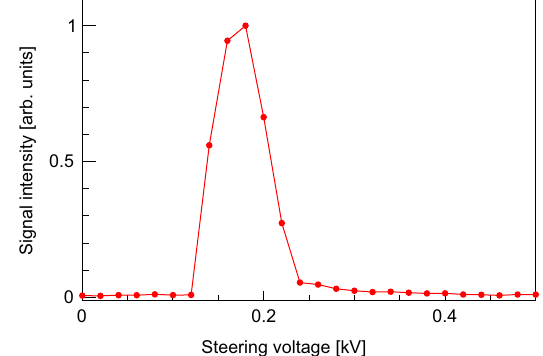
FIG. 20. Signal intensity as a function of steering voltage for lens voltage of 3.5 kV.